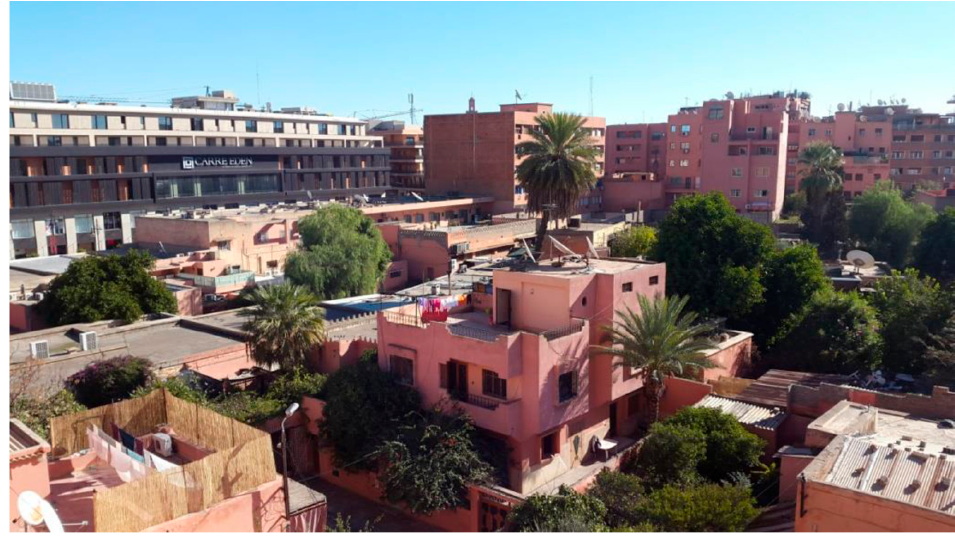
Figure 13. Panoramic view of the centre of Guéliz.